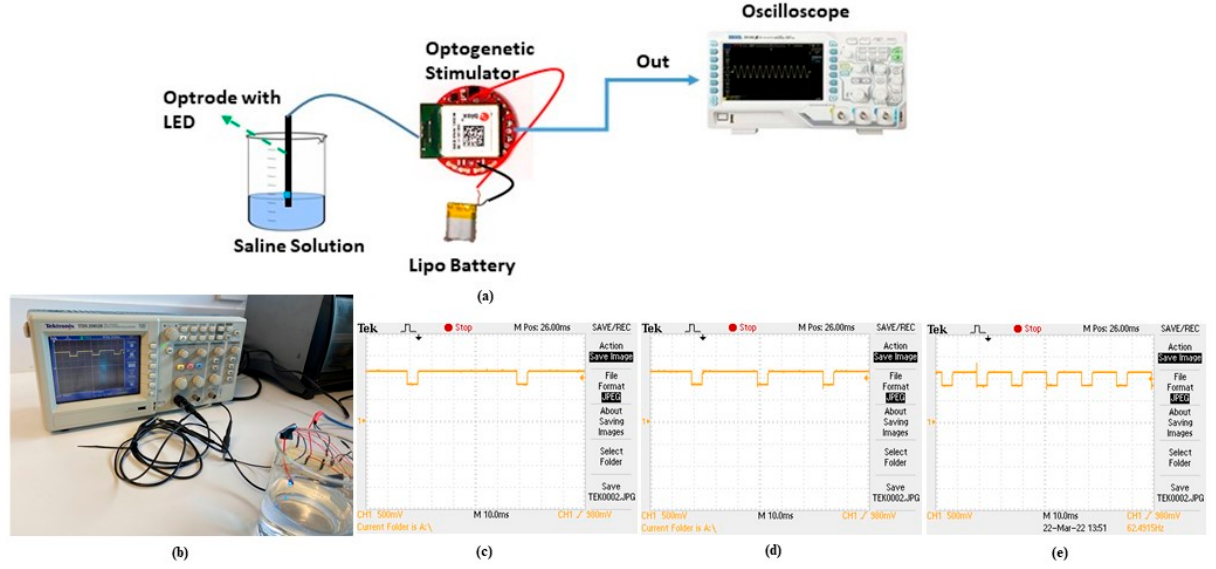
Figure 12. ( a ) Experimental design for the optogenetic stimulator, ( b ) experimental setup for validation of the optogenetic stimulator, ( c ) stimulation pulses for class 2, ( d ) stimulation pulses for class 3, and ( e ) stimulation pulses for class 4.